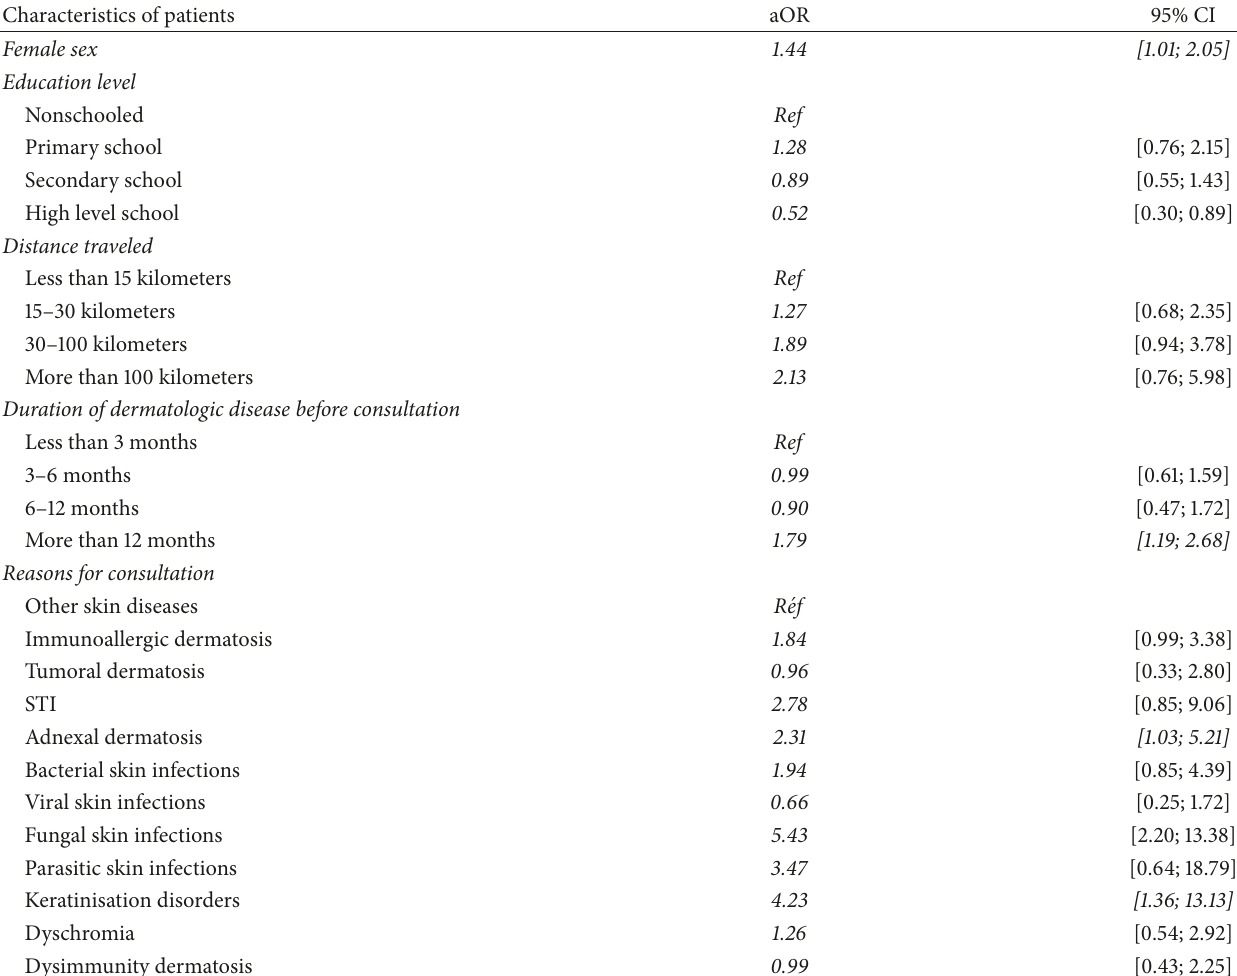
Table 2: Factors associated with self-medication among patients with dermatologic diseases in Lom´e, 2016. Characteristics of